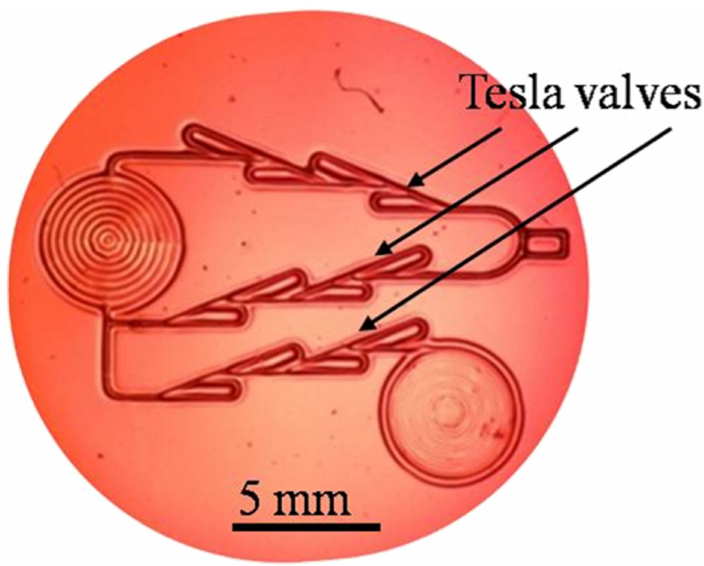
Figure 9. Complex microfluidic channels, with three Tesla valves formed on a tot’hema-gelatin. Physicochemical processes during interaction with light depend strongly on the laser beam power and focus. The sensitivity threshold is reached at approximately 7.5 nJ/ µ m 2 of laser energy, which is easily achieved by focusing the laser beam through the long-working– distance microscope objective (Mitutoyo 20 × , 0.4 NA). By appropriately controlling the laser beam size and power, irradiation time and writing speed, features can be fabricated with characteristic widths between 10 µ m and 1000 µ m and depths up to several hundred micrometers. By using high-power lasers, fabrication time can be significantly